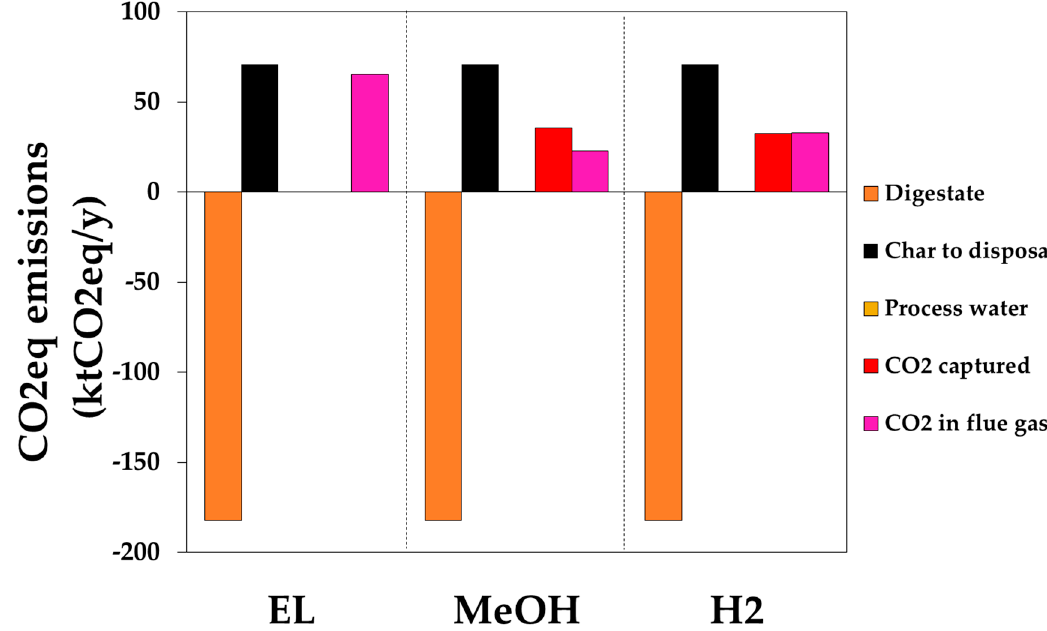
Figure 7. Annual CO 2 -equivalent emissions for EL, MeOH, and H 2 cases. Savings from digestate disposal (orange bars), emissions from solid residual after gasification (black bars, process water (yellow bars), CO 2 captured in Selexol process (red bars), and combustion of syngas/purge gas (rose bars). Calculation base: 100 kt/year of digestate.